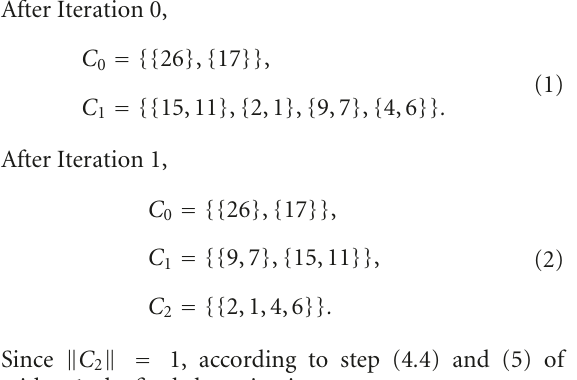
until no more matches can be made. The centroid/average of each cluster pair is calculated, and then, with the leftover clusters excluded, the entire new set of the paired clusters is subjected to the same pairing operation under the constraint of the same threshold T in the next